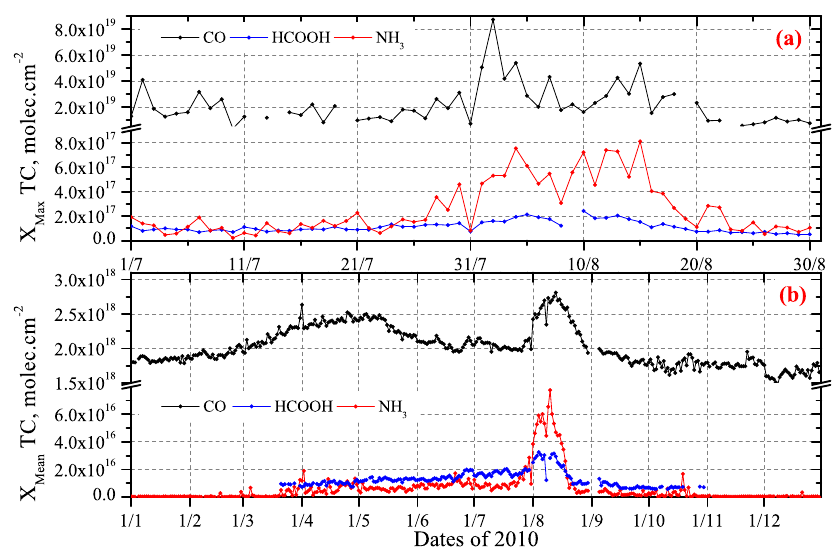
Fig. 2. (a) Temporal evolution of CO (black), NH 3 (red) and HCOOH (blue) total column maximums between 1 July and 1 September 2010. (b) Mean total column over the area 40–75 ◦ N, 30–150 ◦ N for CO, NH 3 and HCOOH, for the year 2010. Only retrievals with spectral residual root-mean-square less than 3 × 10 − 7 and 3 × 10 − 6 Wm − 2 sr − 1 m for CO and NH 3 , respectively, were considered here.